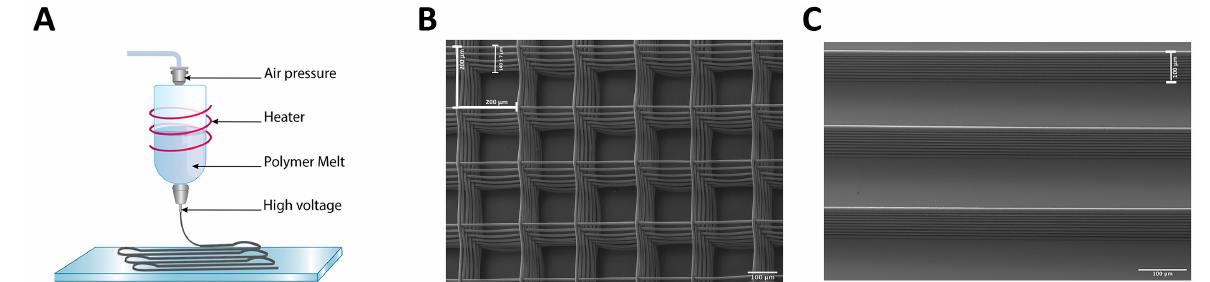
Figure 1. Fabrication and design of 3D scaffolds and aligned microfibers have similar properties. ( A ) Schematic representation of melt electrowriting. Medical grade PCL melt was extruded through an electrified nozzle into a jet that solidified upon reaching the collector. Repeated deposition enabled the fabrication of a 9 mm diameter scaffold or an 8 mm long array of aligned microfibers. ( B ) Scanning electron microscopy image of a scaffold consisting of 10 stacked aligned fibers along the length and 20 stacked overlapping aligned fibers at each corner, where each fiber has a diameter of 10 µ m. The interfiber bundle distance is 200 µ m (indicated as a white bar) with an overall box form scaffold structure with the total height of the fiber walls ~ 140 ± 7 µ m as indicated (in white). ( C ) Scanning electron microscopy image of aligned microfibers. Each fiber bundle tract consists of 10 stacked aligned fibers where each PCL fiber is 10 µ m in diameter with the total height of the fiber walls 106 ± 15 µ m (indicated as a white bar). The interfiber bundle distance is 200 µ m.